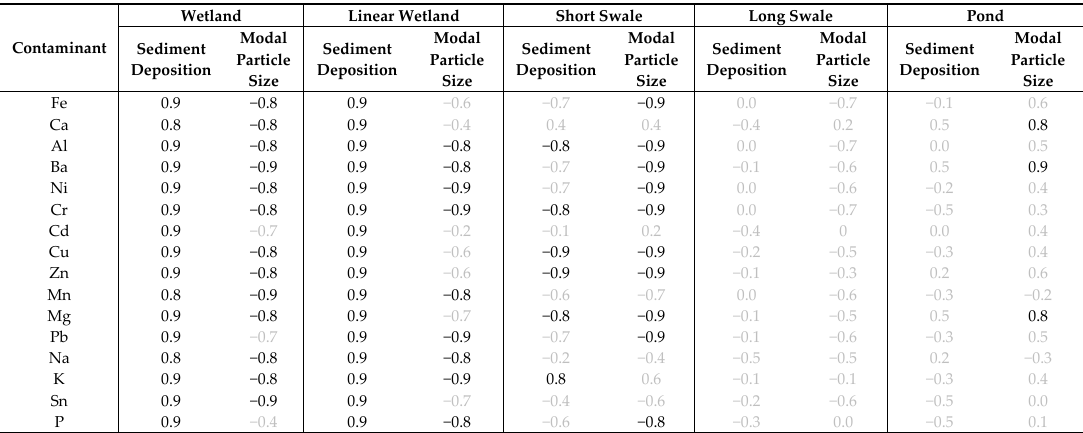
Table 7. Correlation coefficient results for average contaminant concentrations, sediment deposition and deposited sediment modal particle size for each SuDS asset. Strong correlations are presented in black, minor and moderate correlations and presented in grey.